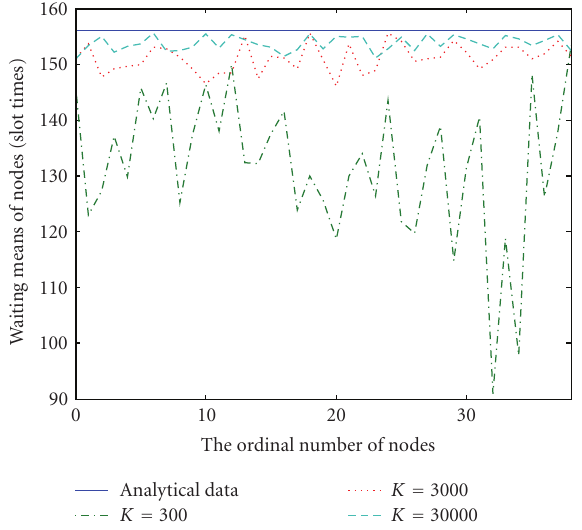
Figure 3: Waiting means of 50-node optical TDMA